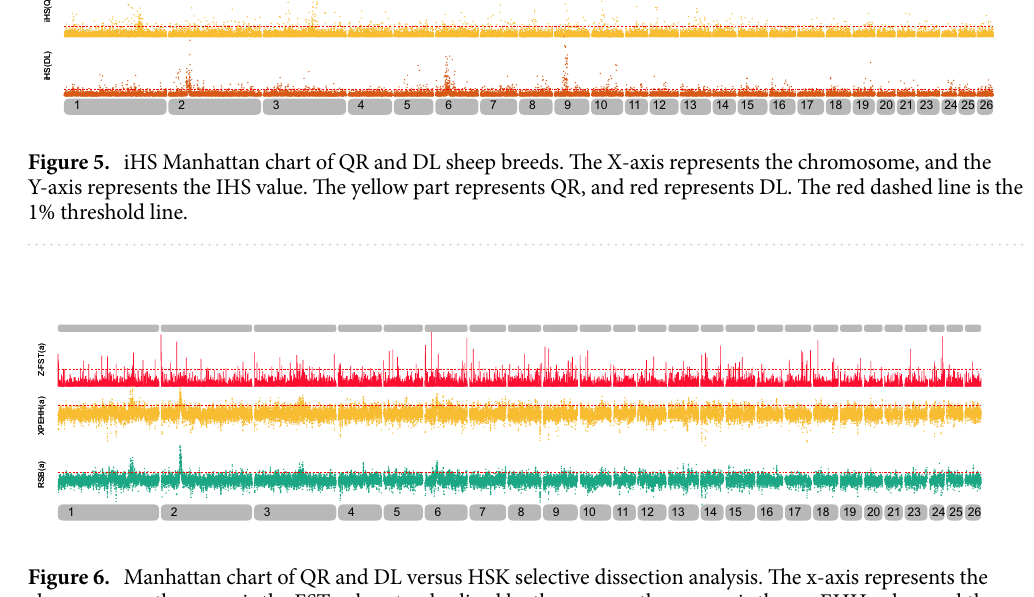
Figure 6. Manhattan chart of QR and DL versus HSK selective dissection analysis. The x-axis represents the chromosome, the green is the FST value standardized by the z-score, the orange is the xp-EHH value, and the black is the Rsb